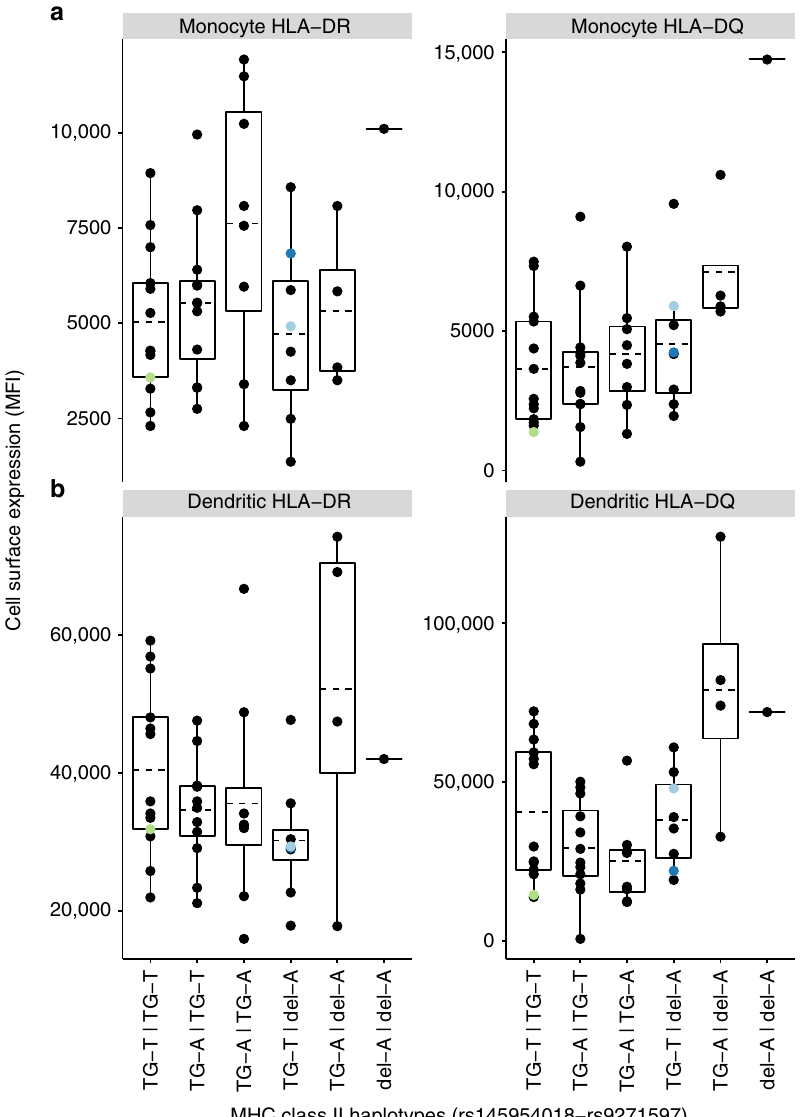
Fig. 5 HLA-DQ and -DR protein expression by rs145954018-rs9271597 genotype. a Monocytes (CD3 − , CD11b + , CD11c − , CD14 + , CD19 − ); b Dendritic cells (CD3 − , CD11b − , CD11c + , CD14 − , CD19 − ). HLA-DQ and HLA-DR cell surface expression is calculated as mean fl uorescence intensity (MFI). Phased rs145954018-rs9271597 genotypes are indicated (GT-T | GT-T, n = 13; GT-T | GT-A, n = 12; GT-A | GT-A, n = 8; GT-T | del-A, n = 8; GT-A | del-A, n = 4; del-A | del-A, n = 1). Circles indicate individual subjects (one measurement per subject), dashed lines denote means, boxes denote fi rst through third quantiles. Each vertical bar extends from the box to the largest or smallest value no farther than 1.5 times the inter-quartile range. Data beyond the vertical bars are considered outliers and are plotted individually. Colored circles represent subjects for whom whole-blood RNA-seq data are presented in Table 2 (green, subject 1; dark blue, subject 2; light blue, subject 3). Source data are provided as a Source Data fi